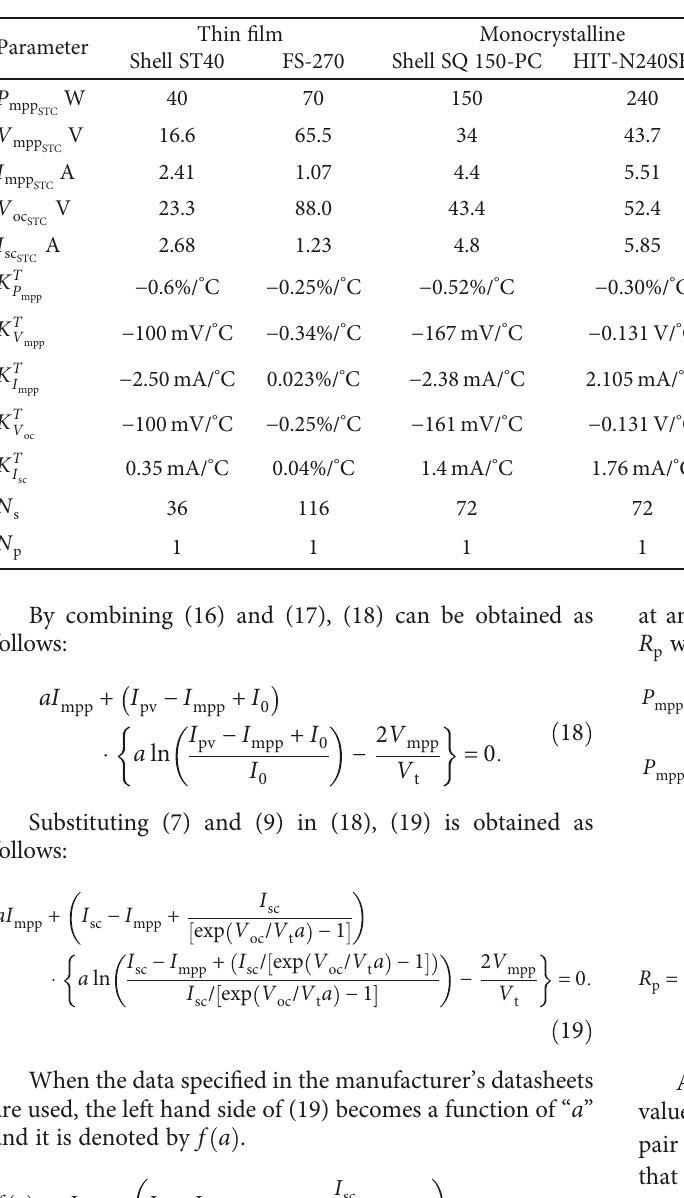
Table 1: Parameters of seven di ff erent commercially available PV modules at STC (25 ° C and 1000 W/m 2 ) provided by the manufacturers [30 –